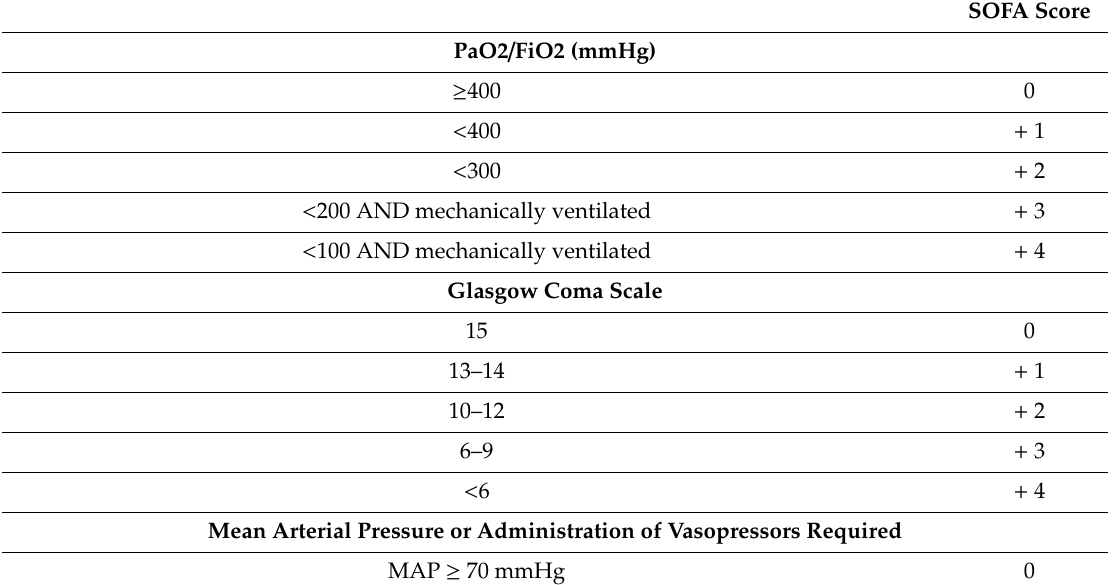
Table 1. Sequential organ failure assessment (SOFA) score.